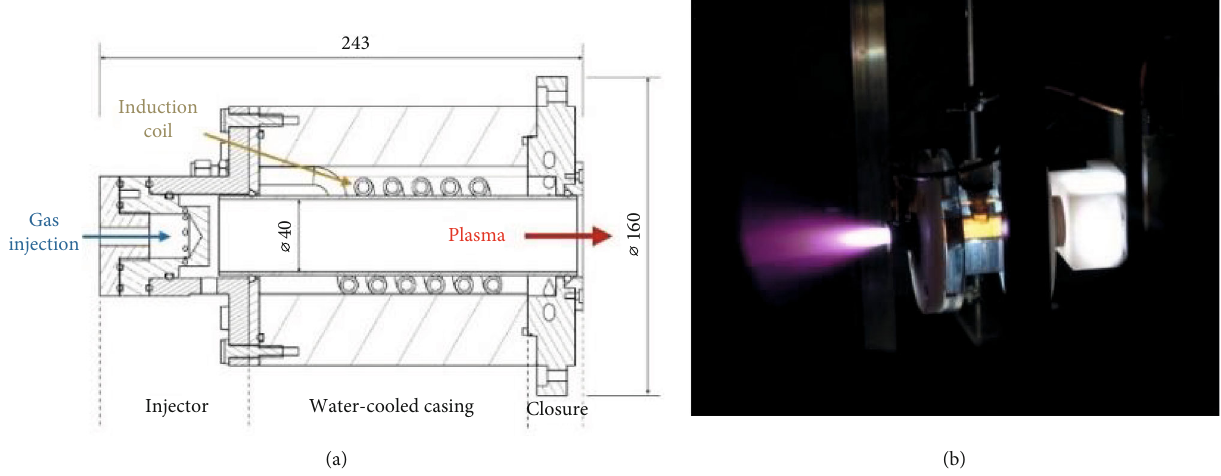
Figure 24: Variable Inlet feeding atmosphere-breathing PPT for Electrode eRo-sion measurements (VIPER): (a) schematic of VIPER in radial-injection con fi guration; (b) VIPER in operation